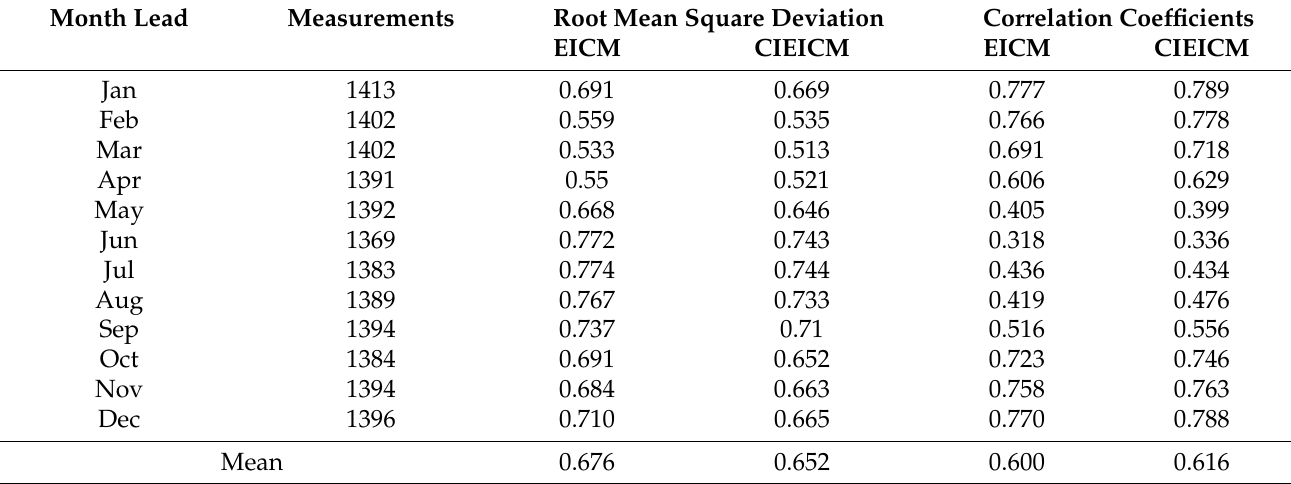
Table 3. Comparison of accuracy between EICM and CIEICM with in situ data.